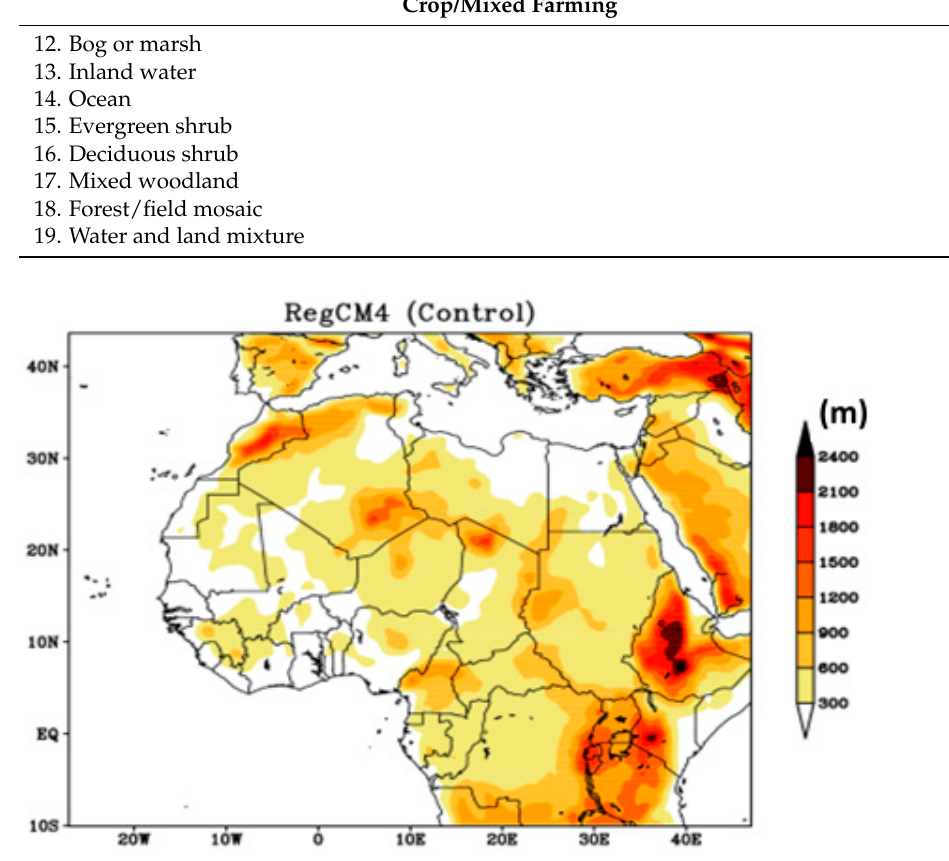
Figure 1. Topography (m) of the simulation domain (West Africa) from the RegCM4 model.